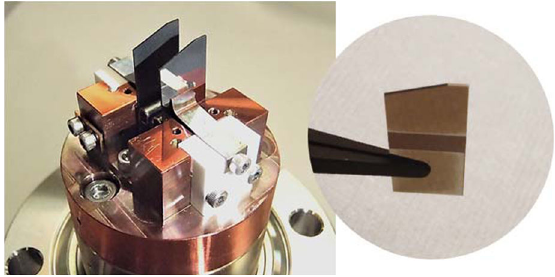
FIG. 13. Photographs of the heat sink holder (left) and the detection elements (right).